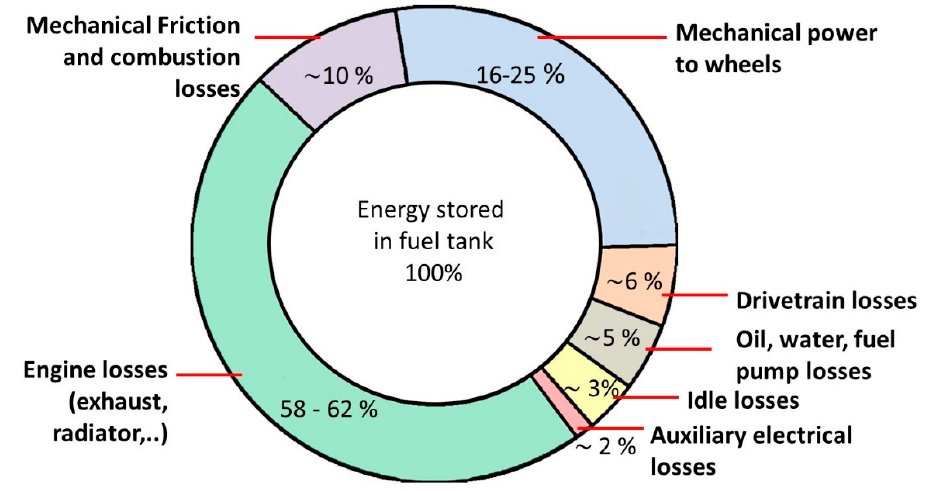
Figure 1. Energy requirements for combined city / highway driving (adapted from [1]).